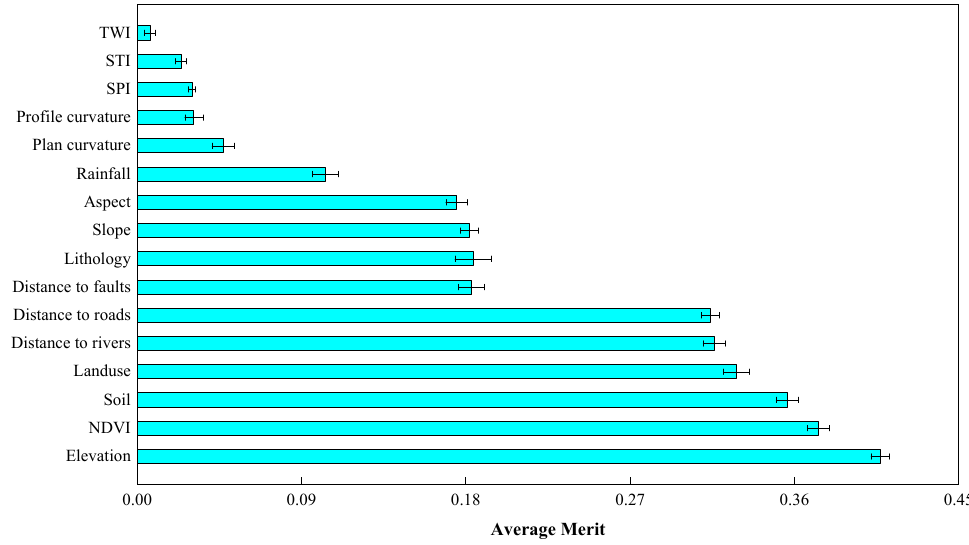
Figure 6. The prediction ability of landslide conditioning factors.